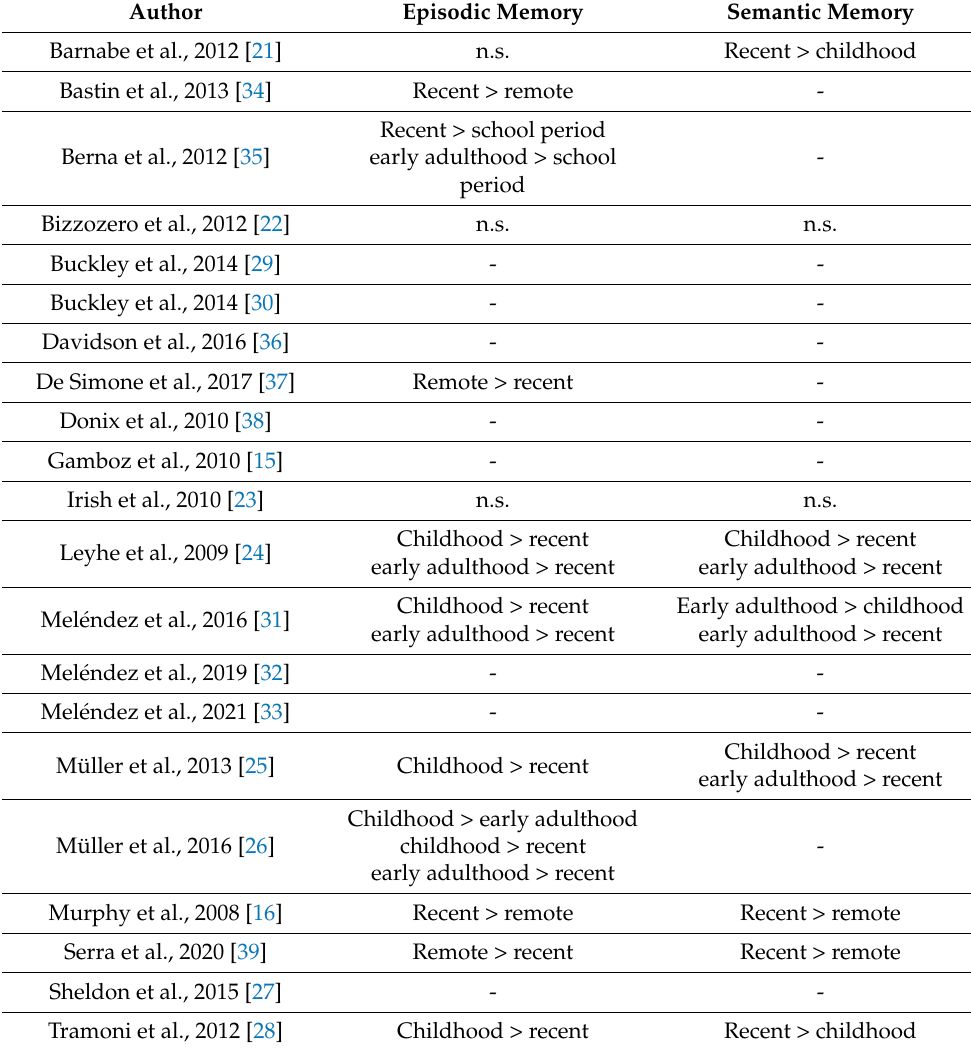
Table 6. Temporal gradient in the autobiographical memory performance in MCI